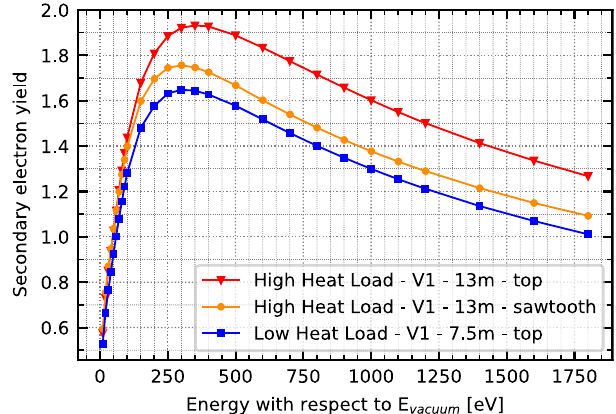
Fig. 4 Secondary electron yield (SEY) curves. SEY curves of the top side of beam screen sections in the fi eld region of V1 beam screens from High Heat Load (red) and Low Heat Load (blue) LHC dipoles and sawtooth side of High Heat Load beam screen